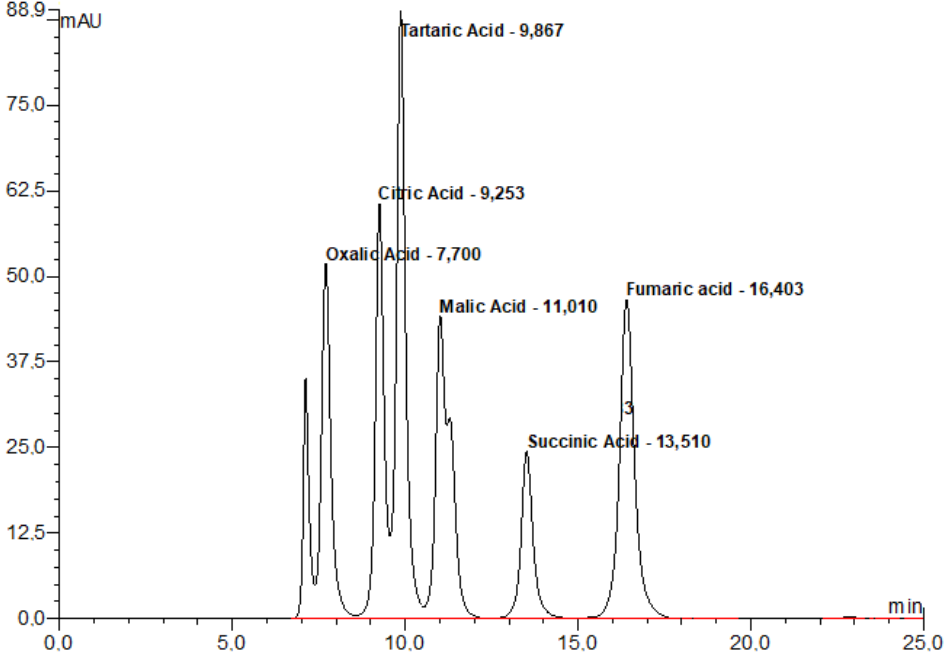
Figure 2. Chromatogram of organic acid